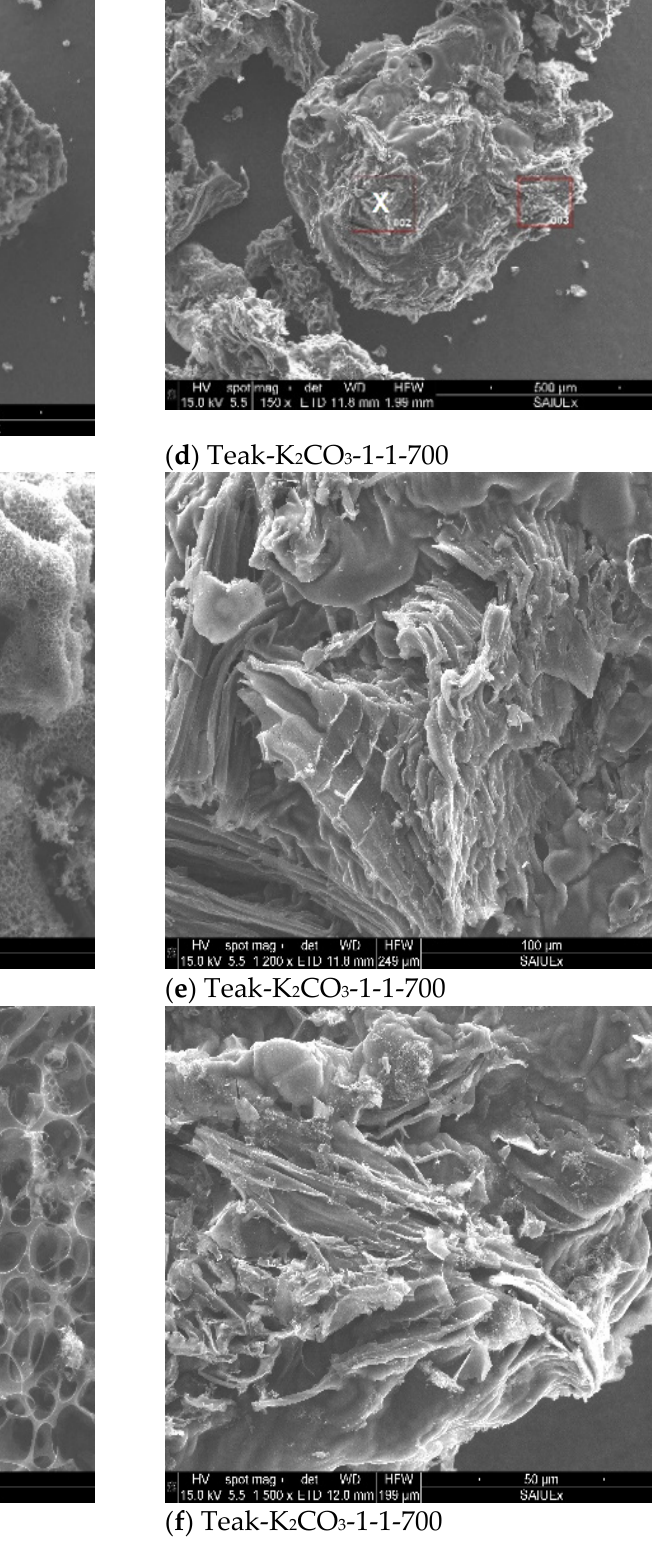
Figure 2. Representative SEM images obtained from Teak-KOH-1-1-700 and Teak-K 2 CO 3 -1-1-700. The images ( b , c ) are the amplifications of the points identified with an X, on image ( a ). On the images, each mark corresponds to 500 µ m on the images ( d ), 100 µ m on the images ( e ), 20 µ m Teak-KOH-1-1-700 ( c ) and 50 µ m Teak-K 2 CO 3 -1-1-700 ( f